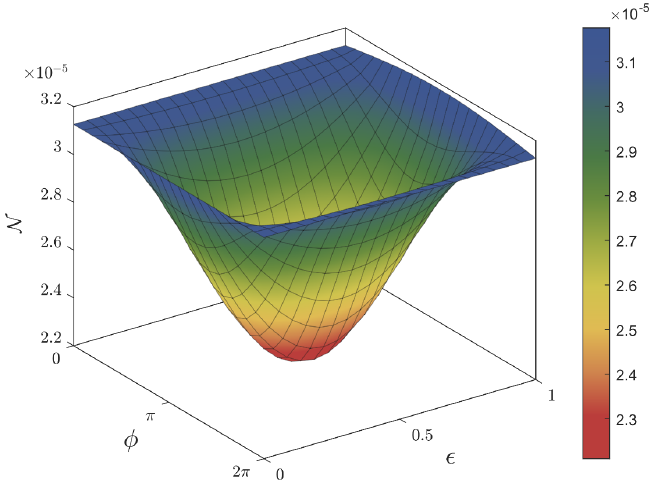
Figure 4 . The negativity of the outcome states vs φ and (cid:15) with the initial states ρ ( φ, (cid:15) ) , m 1 = m 2 = m , G N m 2 = 10 − 5 , | b | m = 10 , p/m = 100 , C 1 , 2 = C 2 , 2 = 1